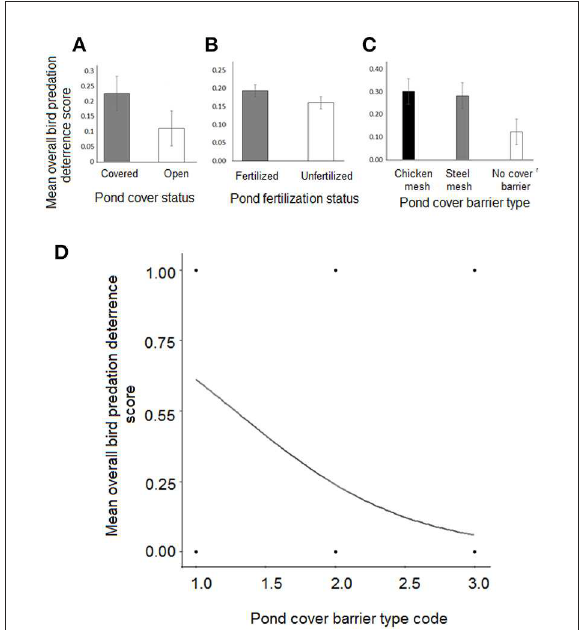
FIGURE3 Effect of (A) Pond cover status, (B) Enhanced pond fertilization, and (C) Pond cover barrier type on bird predation deterrence success rate. (D) Logistic regression curve showing influence of pond cover barrier type on success rate of bird predation deterrence. Pond cover barrier type is coded on a rank score ranging from 1 = chicken-mesh; 2 = steel-mesh, to 3 = no cover barrier. Mean bird deterrence scores are daily averages for the total number of days of